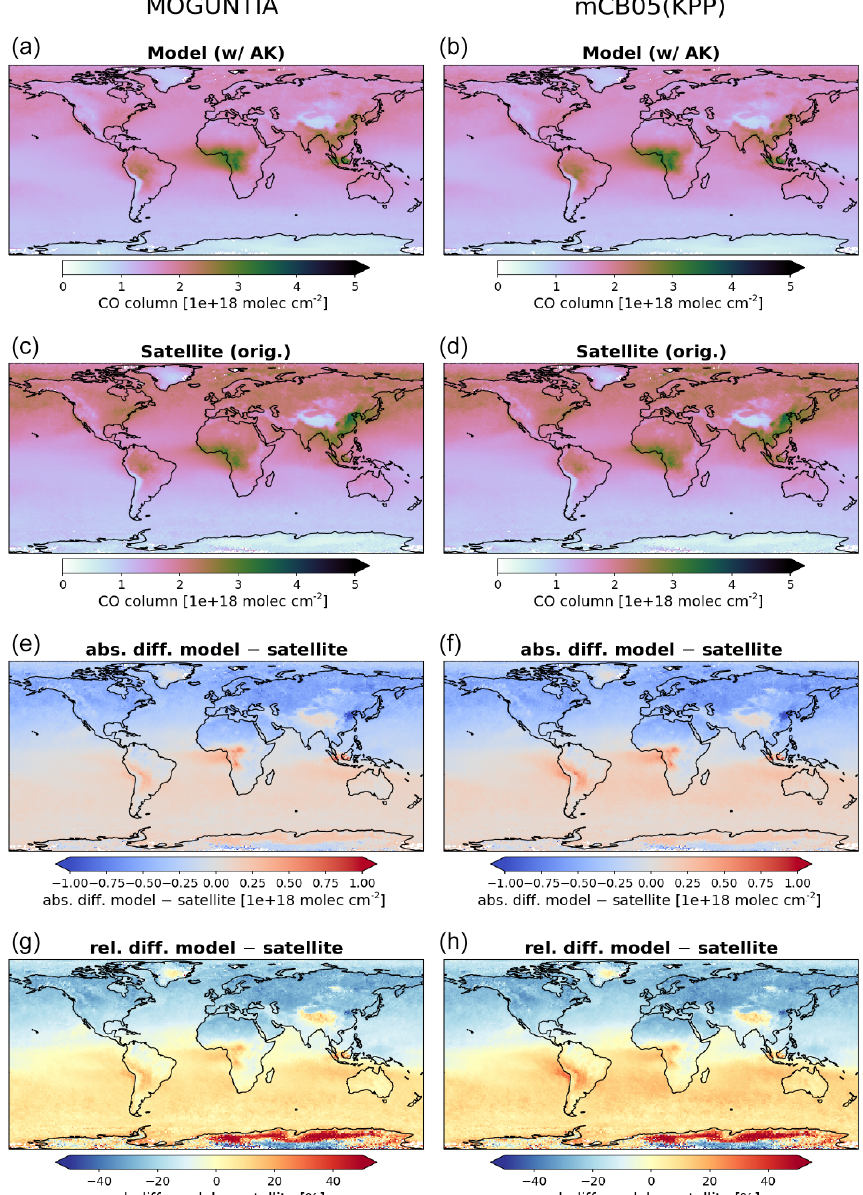
Figure 8. Annual mean comparison of total CO vertical columns (molec.cm − 2 ) for the two chemistry schemes of TM5-MP, MOGUNTIA and mCB05(KPP) (a, b) against MOPITT satellite data (c, d) , using the respective averaging kernel information for 2006. The absolute (e, f) and relative (g, h) differences are also